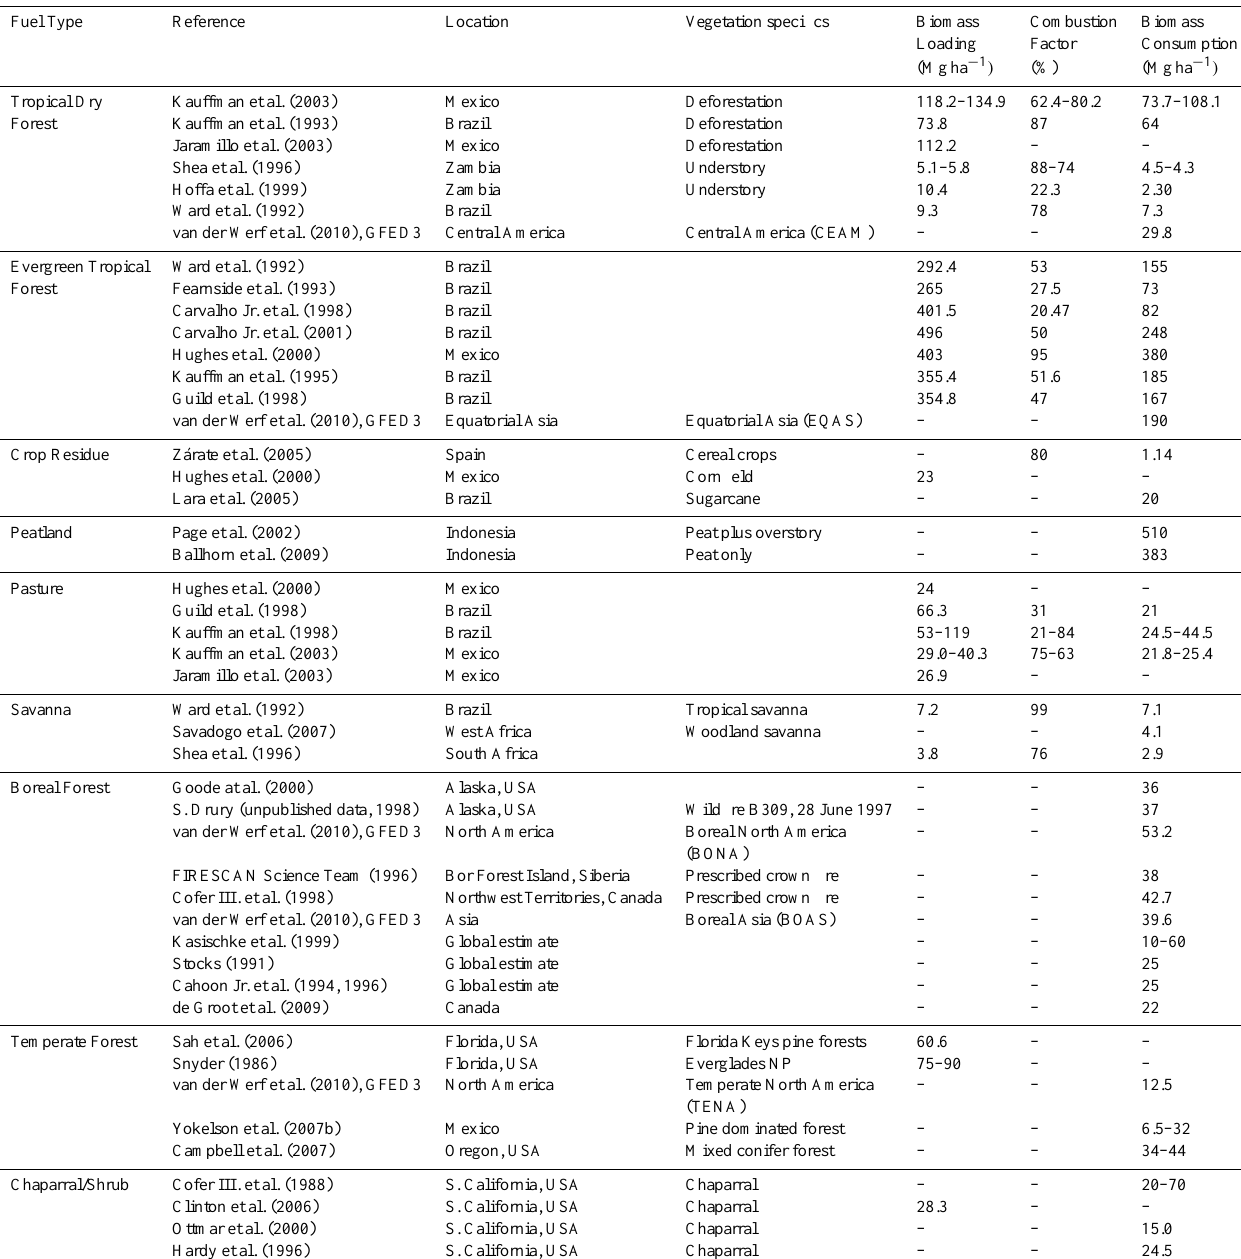
Table 3. Biomass loading, combustion factor, and biomass consumption estimates for various fuel